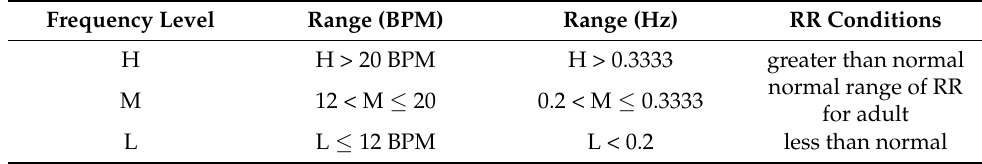
Table 1. Frequency level versus frequency